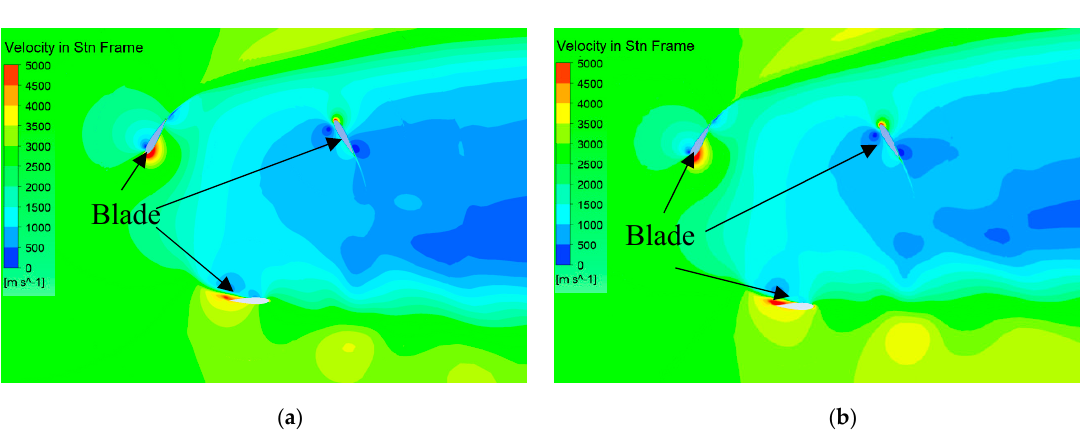
( c ) Figure 14. Lateral force, thrust and torque coefficient curve, ( a ) thrust coefficient curves of stand-alone turbine and twin-rotors system, ( b ) lateral force coefficient curves of stand-alone turbine and twin-rotors system, ( c ) torque coefficient curves of stand-alone turbine and twin-rotors system. As shown in Figure 13, the cyclic variation tendency of blade loads coefficients of stand-alone turbine and twin-rotors system are basically the same. The blade coefficient of the twin-rotors system is bigger than that of single turbine by less than 5% at the peak point. It can be inferred that the interaction between the two turbines has very little effect on the loads of the turbine blades for the twin-rotors system. This is beneficial for the structure strength design of twin-rotors blades, and designers can focus more on increasing the power output efficiency of the turbine without considering much about the structure strength of the blades. As shown in Figure 14a and Figure 14b, there is a slight difference in the thrust and lateral force between the two different configurations. The thrust and lateral force coefficients of the twin-rotors system is a little higher than that of the stand-alone turbine by less than 7%, but the cyclic variation tendency of lateral force, thrust and torque of the twin-rotors and single turbine tends to be the same. Since the thrust and lateral force acts on the main shaft, therefore, we should consider more about the structural strength as well as fatigue strength when selecting the appropriate main shaft for the twin-rotors system. Meanwhile, as is shown in Figure 14b, the positive and negative distributions of the lateral force of the twin rotors are symmetrical about the x axis. Compared with the stand-alone turbine, the symmetrical distribution of lateral loads benefits the fatigue life of the twin rotors. In fact, the average lateral force coefficient slightly fluctuates around 0 for the twin rotors. In addition, as is shown in Figure 14c, the torque coefficient of the twin-rotors system increases compared with the